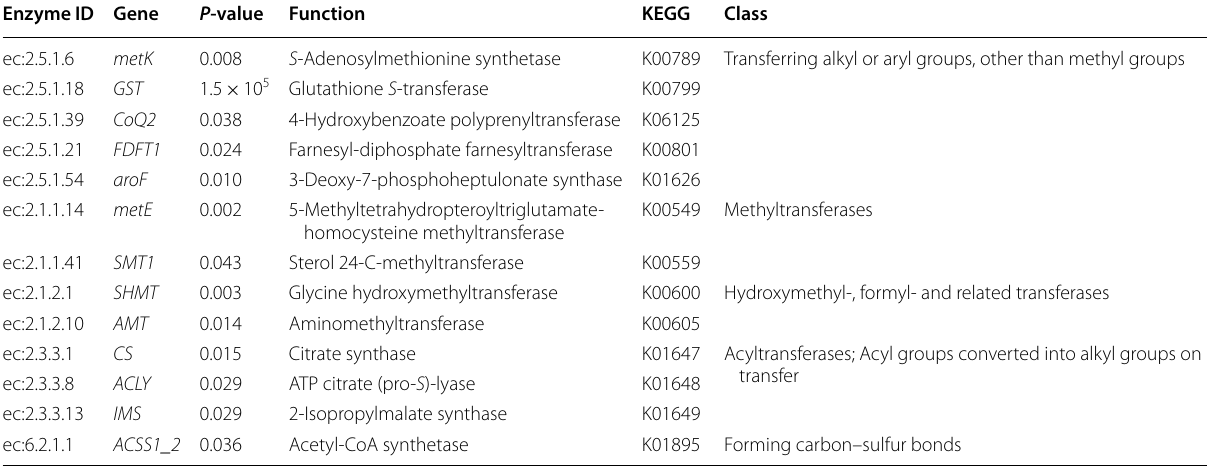
Table 2 Critical upregulated proteins based on proteomic analysis (10-day samples)